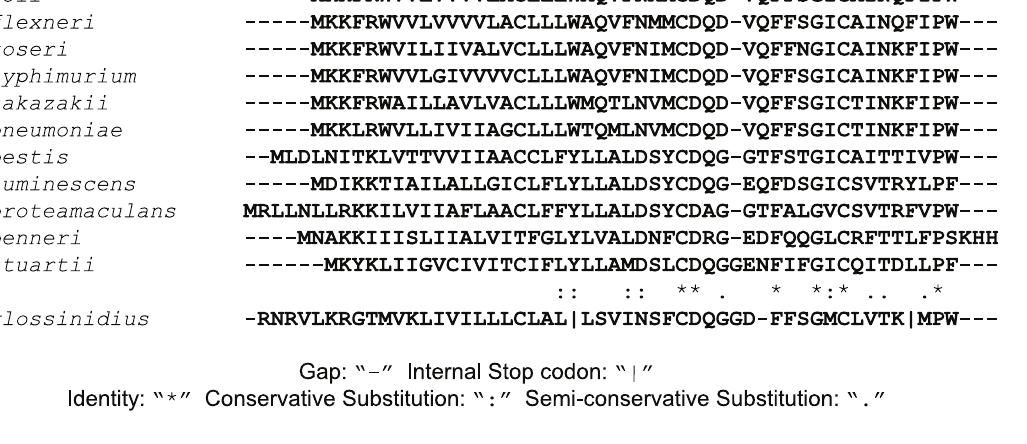
Figure 6. MgrB homologs identified from genome sequences of various genera of Enterobacteriaceae. The first 11 sequences were aligned using ClustalW [54]. Genome sequences were from Escherichia coli MG1655, Shigella flexneri 2457T, Citrobacter koseri ATCC BAA-895, Salmonella typhimurium LT2, Enterobacter sakazakii ATCC BAA-894, Klebsiella pneumoniae 342, Yersinia pestis KIM, Photorhabdus luminescens subsp. laumondii TTO1, Serratia proteamaculans 568, Providencia stuartii ATCC 25827, Sodalis glossinidius str. ‘morsitans’, and Proteus penneri ATCC